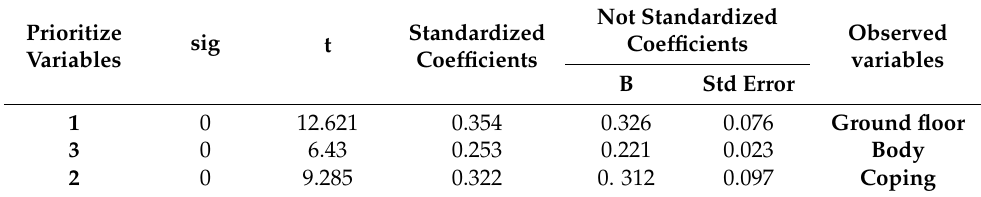
Table 9. Beta coefficients of the criteria constituting the partial perception (Source: Authors). Prioritize